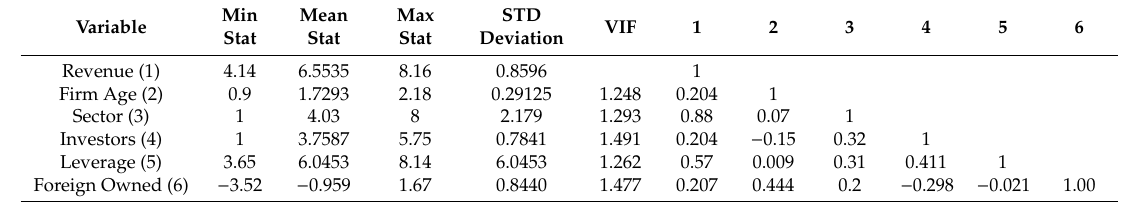
Table 1. Standardized Variable itemization, descriptive statistics, and correlation